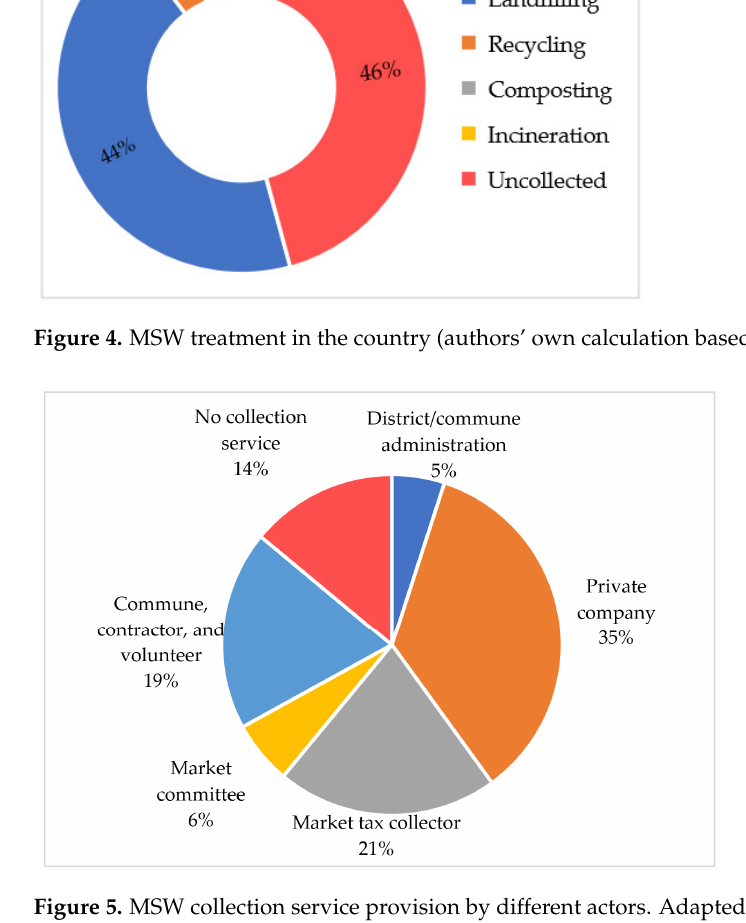
Figure 5. MSW collection service provision by different actors. Adapted from [27].